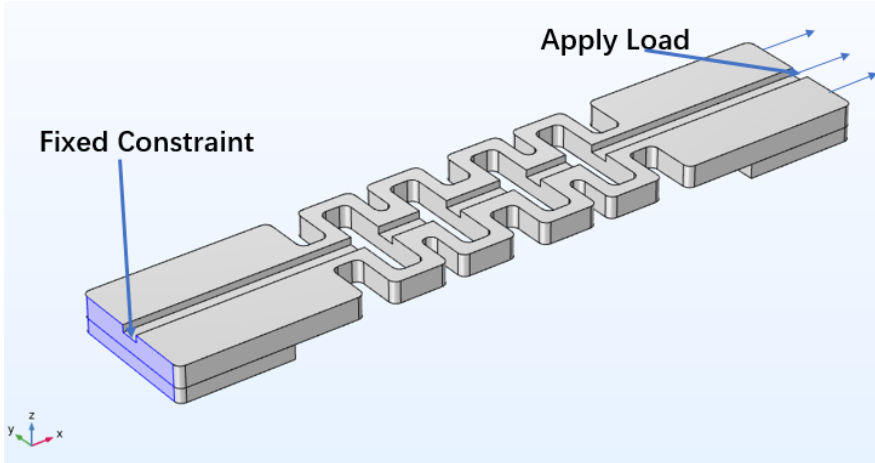
Figure 2. Structural simulation model. The highlighted region represents the fixed constraint. The arrow is the direction of load application.